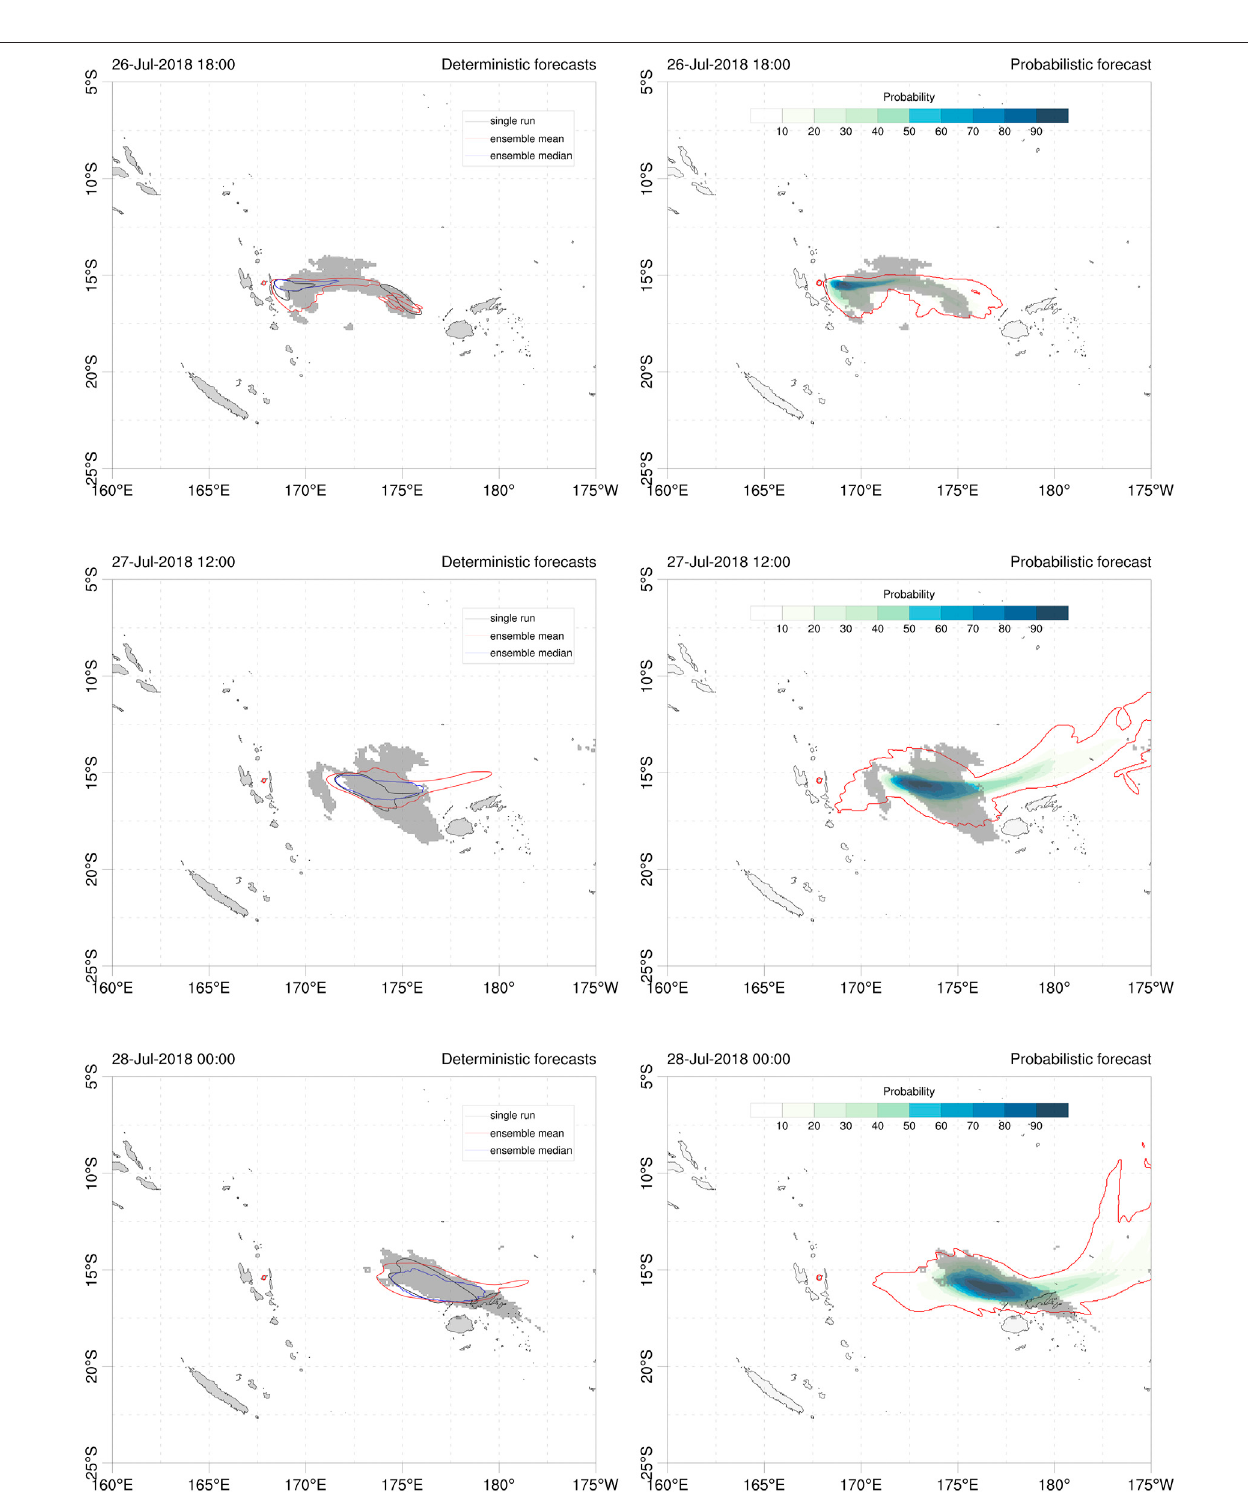
FIGURE 3 | Contours of 20 DU SO 2 column mass for deterministic (left) and probabilistic (right) Ambae forecasts at three different instants; 26 July at 18:00UTC (top) , 27 July at 12:00 UTC (middle) and 28 July at 00:00UTC (bottom) . In the probabilistic approach, contours give the probability (in % ) to exceed 20 DU. The outer red contour indicates the 1.56% (1/64) probability. The grey shaded area shows the corresponding 20 DU from AHI retrievals. Red circle shows the location of Ambae volcano.